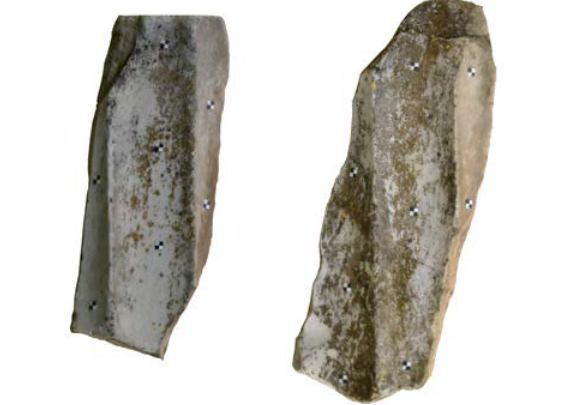
Figure 3.Fragments of Doric column drum, found at the site of Nicias monument. Control points were used as scale bars in Agisoft PhotoScan ®